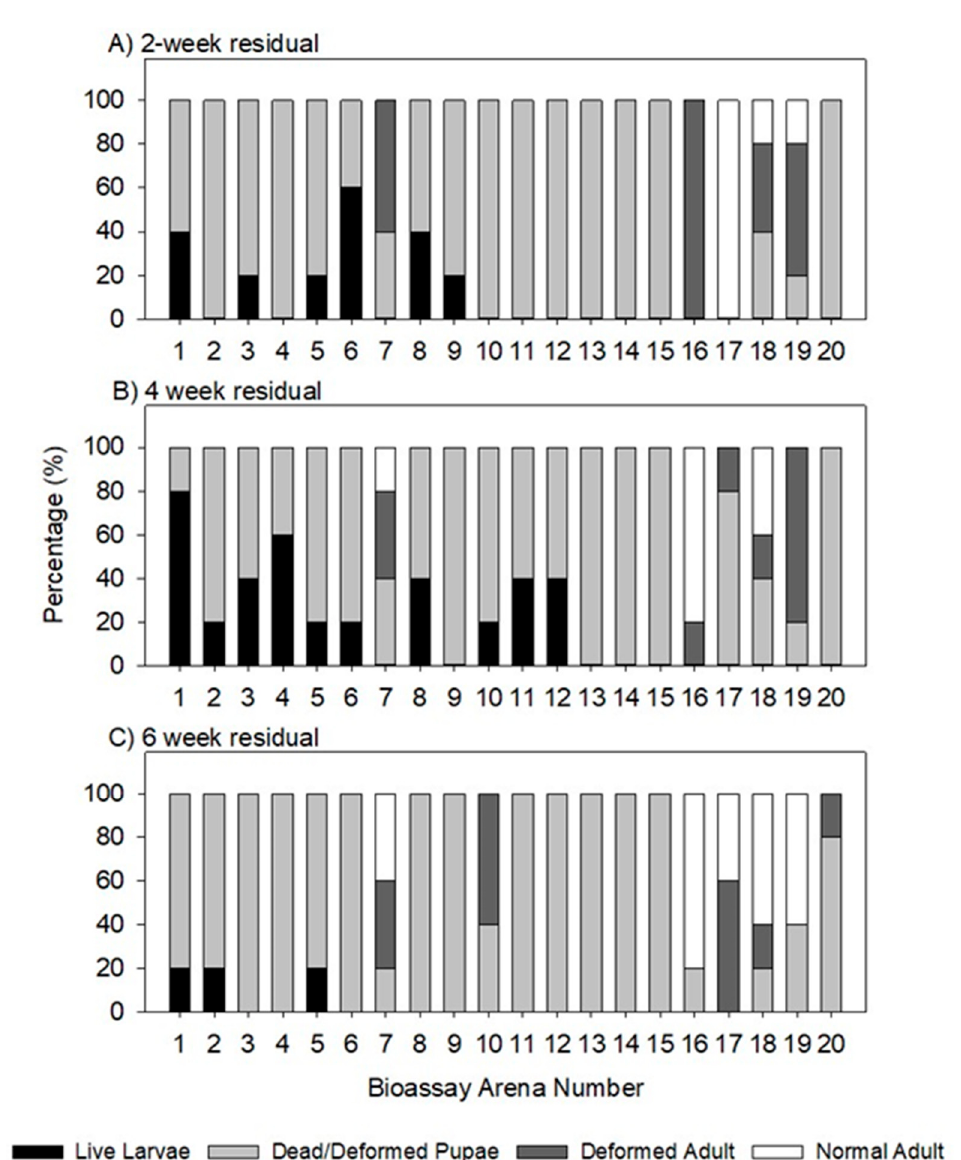
Figure 6. The percent of larvae, pupae (dead or deformed), deformed adult, or normal adults after larvae were exposed to aerosol exposed concrete arenas ( A ) two weeks post aerosol treatment; ( B ) four weeks post aerosol treatment; and ( C ) six weeks post aerosol treatment.